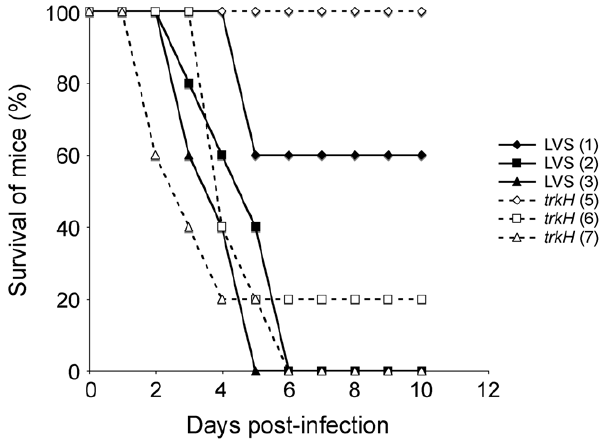
Figure 7. The trkH mutant is attenuated for virulence in mice. Groups of five BALB/c mice were infected with LVS (closed symbols) or trkH (open symbols) bacteria at different doses by the i.p. route. The log 10 of the numbers of bacteria used for infection are shown in legend in parenthesis. The survival of mice (in %) was followed for 10 days after infection.